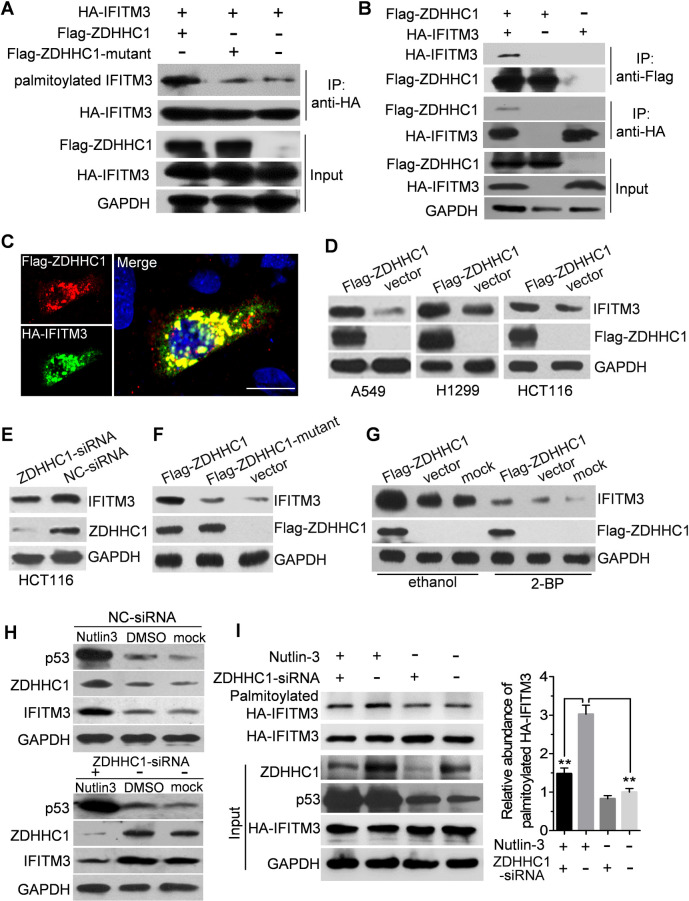
Effect of ZDHHC1 on IFITM3 palmitoylation.(A) HA-IFITM3 was cotransfected with Flag-ZDHHC1 and Flag-ZDHHC1-mutant into HEK293 cells for 36 h, palmitoylated IFITM3 abundance was detected with protein palmitoylation assay. (B) HA-IFITM3 and Flag-ZDHHC1 were cotransfected into HEK293 for 48 h, Co-IP assay was performed with anti-Flag or anti-HA antibody to analyze the interaction of ZDHHC1 and IFITM3. (C) A549 cells were transfected with Flag-ZDHHC1 and HA-IFITM3 plasmids for 24 h, and then stained with anti-Flag and anti-IFITM3 antibodies to analyze fluorensence colocalization. (D) A549, H1299 and HCT116 cells were transfected with Flag-ZDHHC1 construct for 24 h and expression levels of the indicated proteins were determined by western blot. (E) HCT116 cells were transfected with 150 nM ZDHHC1-siRNA or NC-siRNA for 48 h, IFITM3 and ZDHHC1 expression levels were detected by western blot. (F) A549 cells were transfected with 150 nM ZDHHC1-siRNA or NC-siRNA for 48 h, IFITM3 and ZDHHC1 expression levels were detected by western blot. (G) A549 cells were transfected with plasmid expressing Flag-ZDHHC1 for 6 h and then treated with 30 μM 2-BP or equivalent ethanol for 24 h, IFITM3 expression was detected by western blot. (H) A549 cells were treated with 150 nM ZDHHC1-siRNA or control NC-siRNA for 48 h, followed by 20 μM Nutlin-3 or equivalent DMSO for 24 h, and expression levels of the indicated proteins were detected by western blot. (I) A549 cells were treated with 150 nM ZDHHC1-siRNA for 24 h and subsequently transfected with HA-IFITM3 construct for 12 h. The transfectants were then treated with 20 μM Nutlin-3 for 24 h and subjected to protein palmitoylation assay to detect palmitoylated HA-IFITM3 level. Unpaired t test, *P<0.05; **P<0.01.